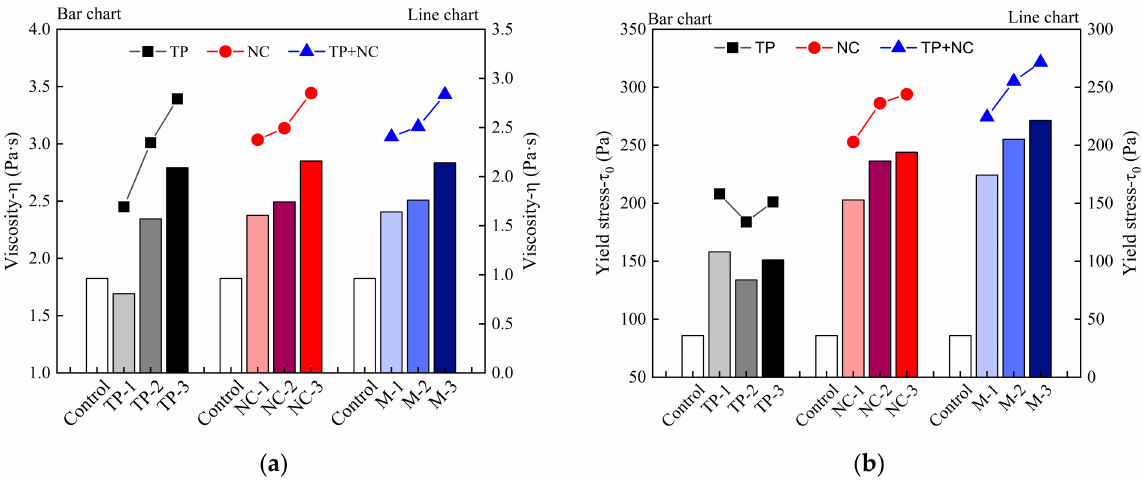
Figure 9. The initial rheological parameters: ( a ) viscosity, ( b ) yield stress of 3DPC that added TP, NC and